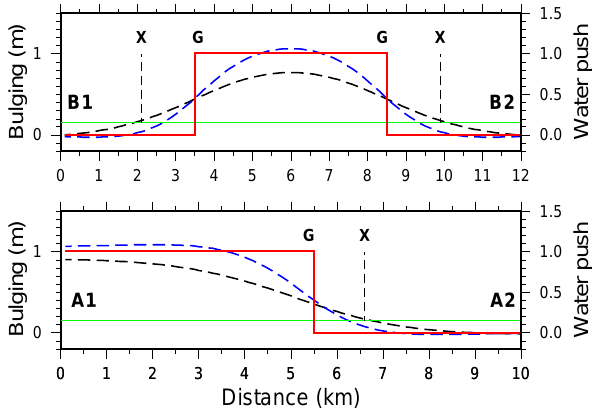
Figure 17. Longitudinal and orthogonal cross sections of both the loading pattern (red) and corresponding ice surface uplift (black) along profiles A1–A2 and B1–B2 of Fig. 16. The green horizon- tal line represents the smallest surface displacement of 0 . 15m de- tectable by the kinematic GPS measurements. Full floatation im- plies a 1m uplift as is almost the case on the left part of the A1–A2 profile (mouth of the fjord). The blue curve shows the same deflec- tion profiles obtained with an elastic modulus ten times smaller than the previously adopted value of 0.9GPa (Vaughan, 1995). The wa- ter push is here expressed as the weight exerted over each cell of the domain (100 × 100 × ρ w gδ ) in 10 8